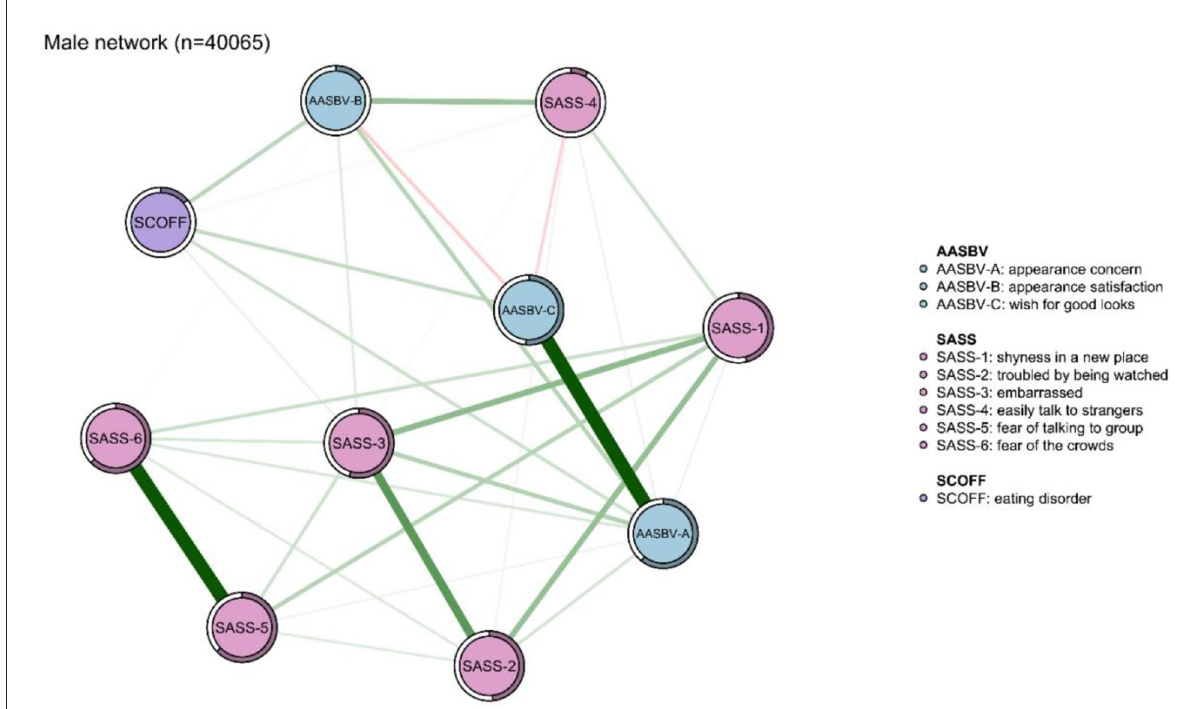
FIGURE2 Network analysis between symptoms of eating disorder (ED), appearance anxiety, and social anxiety disorder (SAD) in the male sample ( n = 40,065). The thickness of the edges indicates the magnitude of the association. Green edges referred to positive associations, while red edges showed negative ones. The circle around the item represents the amount of